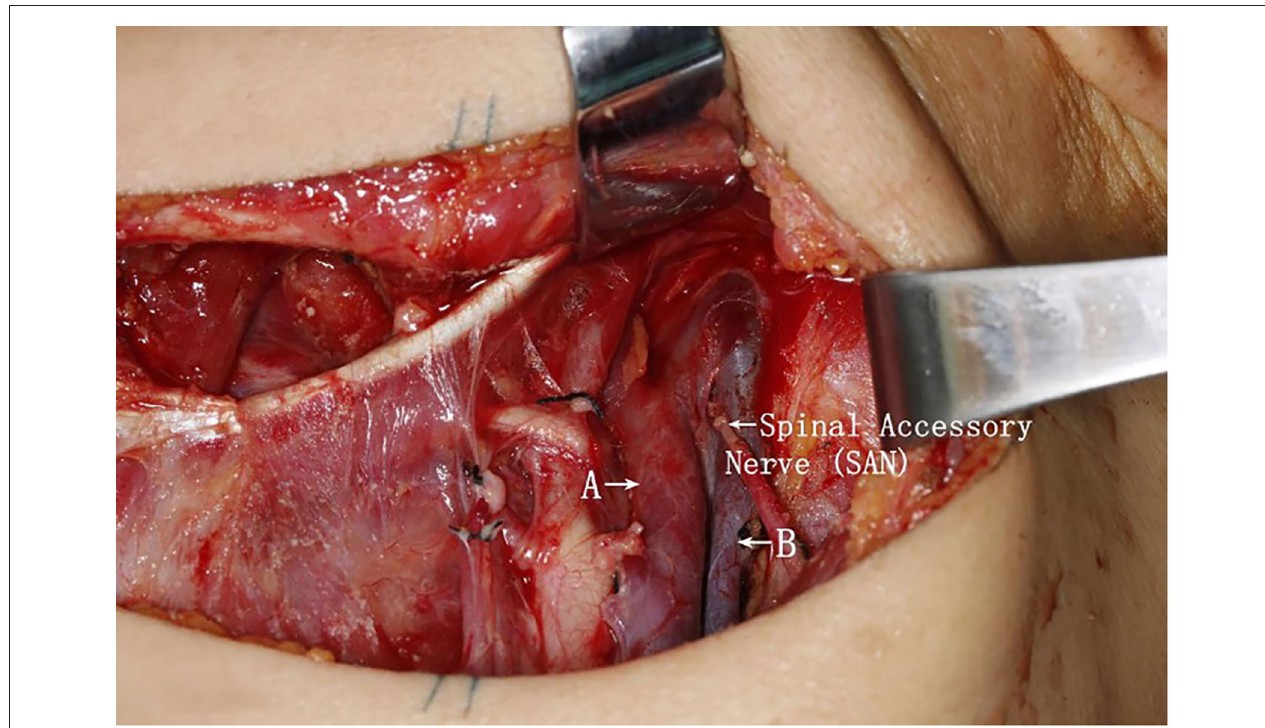
FIGURE 2 | Intraoperative picture of a left-side neck dissection, demonstrating the division of the internal jugular vein into two branches, remaining unfused along the neck area until the level of the omohyoid muscle. This finding represented an internal jugular vein duplication. Additionally, the spinal accessory nerve bisected the two branches (A, anterior branch internal jugular vein; B, posterior branch internal jugular vein; SAN, spinal accessory nerve).